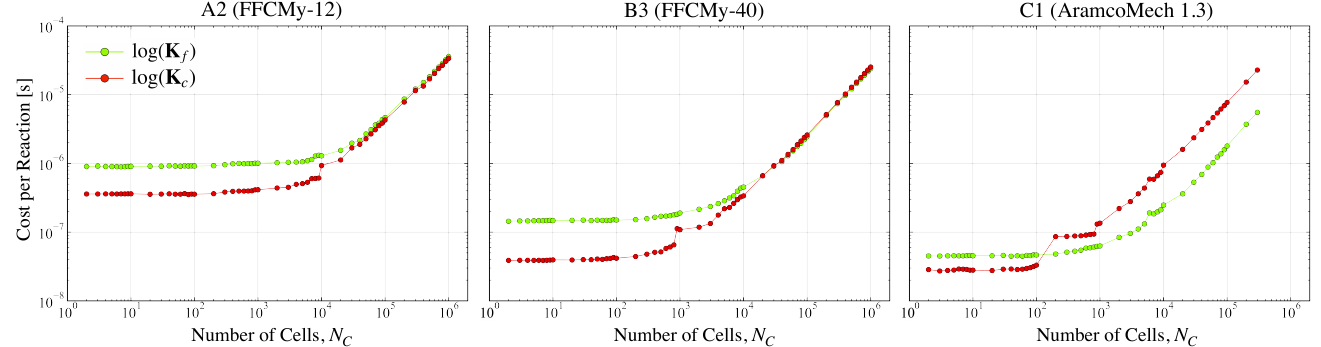
Figure 7. Cost per reaction for forward rate constant (log ( K f ) ) and equilibrium constant (log ( K c ) ) routines as a function of N C for: Mechanism A2 ( left plot); Mechanism B3 ( middle ); and Mechanism C1 ( right